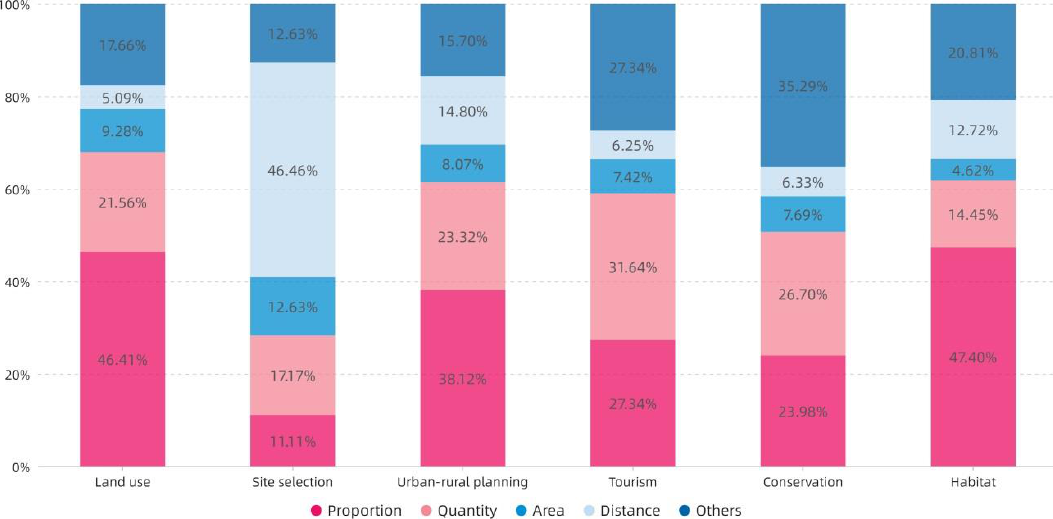
Figure 12. The topic distribution of the proportion of index categories.